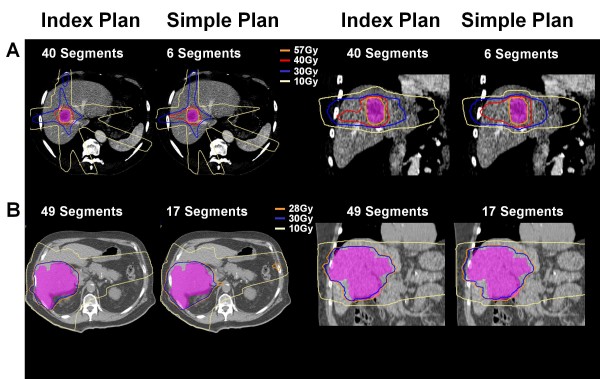
Axial (left panels) and Coronal (right panels) slices of acceptable index and simple IMRT, showing the six fraction, lowest isodose covering 0.5 cc PTV (orange), the 30 Gy isodose (dark blue) and 10 Gy isodose (beige) surrounding the PTV (pink colorwash). Examples are shown of a small lesion typical of liver SBRT (A), where loss of dose conformation of higher isodoses may have larger effects on normal tissue function, as compared to a larger lesion near bowel treated to lower doses (B).